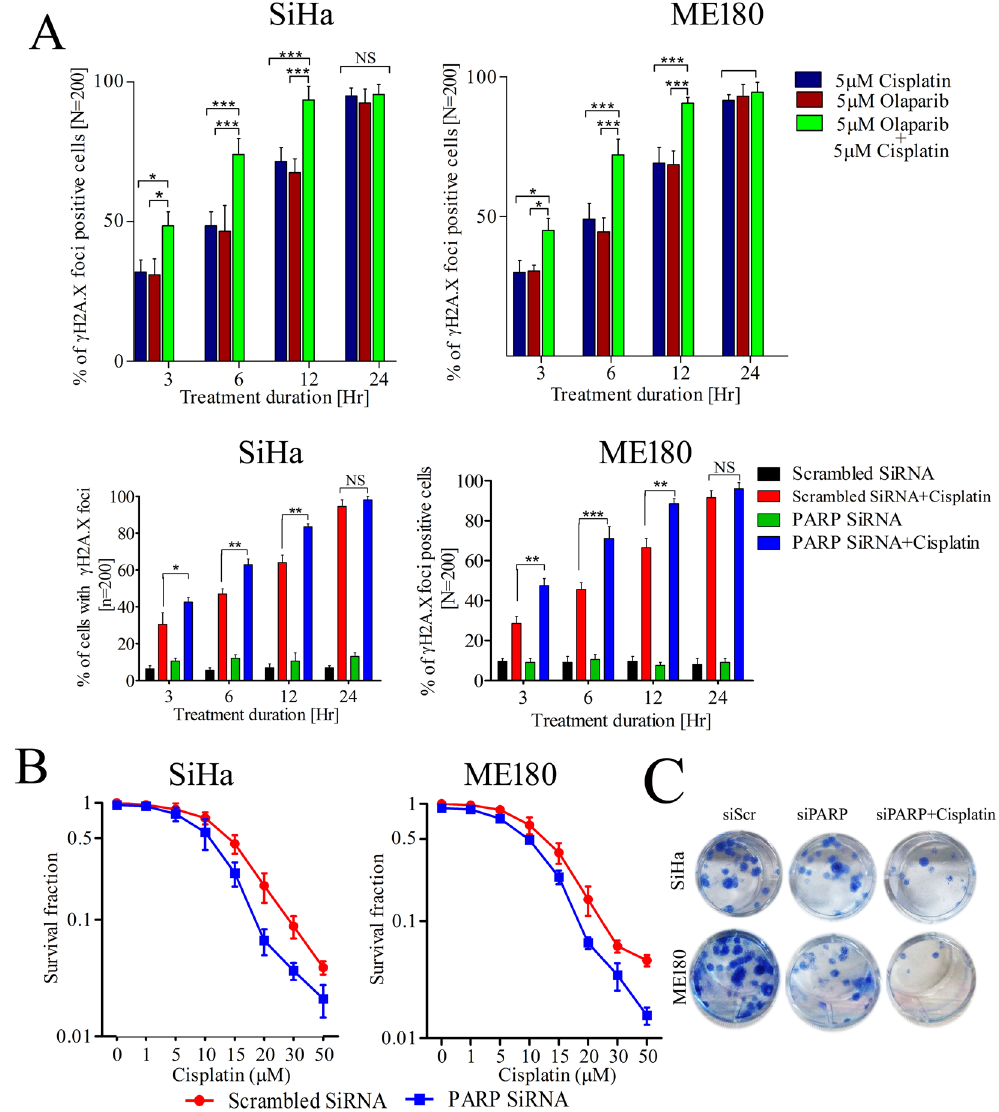
Figure 6. PARP1 inhibition sensitizes CC cells and leads to rapid induction of DNA damage and cell death. ( A ) Bar graph showing the percentage of γ H2A.X foci positive cells (cell with > 20 positive foci/cell as compared to isotype) in indicated groups at particular treatment duration. At least 200 cells were counted in blind fashion in independent duplicate experiment. Error bar show SD from the mean of two independent counts. * p = 0.05, ** p < 0.01, *** p < 0.001 (upper panel); Bar graph showing the percentage of γ H2A.X foci positive cells in PARP1 silenced and control counterpart cells treated with 5 µ M cisplatin for indicated time points. At least 200 cells were counted in blind fashion in independent duplicate experiment. Error bar display SD from the mean of two independent counts. * p = 0.05, ** p < 0.01, *** p < 0.001 (lower panel). ( B ) Cell proliferation assay displaying effect of cisplatin on PARP1 silenced CC cells. ( C ) PARP1 silenced cells showing increased loss of clonogenic survival after cisplatin treatment in CC